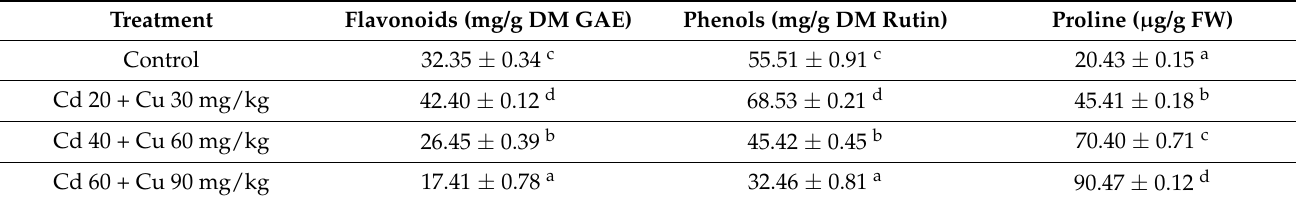
Figure 1. The effect of different Cd and Cu concentrations (0, Cd 20 + Cu 30 mg/kg, Cd 40 + Cu 60 mg/kg, and Cd 60 + Cu 90 mg/kg) on the chlorophyll a ( A ), chlorophyll b ( B ), net-photosynthesis ( C ), transpiration rate ( D ), intercellular CO 2 ( E ), and stomatal conductance ( F ) on the leaves of the pigeon pea. Different letters represent significant differences between the treatments at p ≤ 0.05. Table 2. Total flavonoid, phenolic, and proline contents of pigeon pea under different cadmium and copper concentrations. Various statistical letters represent significant differences from